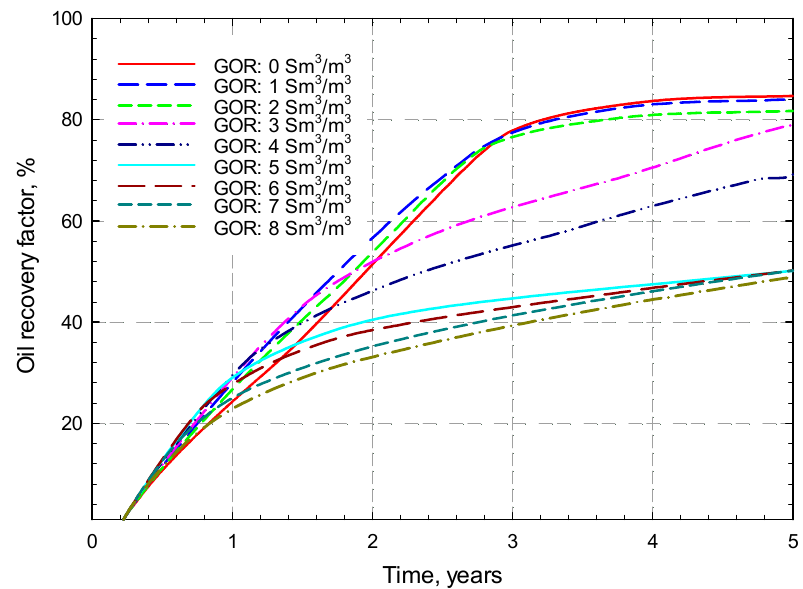
Figure 6. Comparison of the oil recovery factor ( RF ) with different initial gas oil ratio ( GOR ) in the reservoir ranging from 0 to 8 Sm 3 /m 3 .